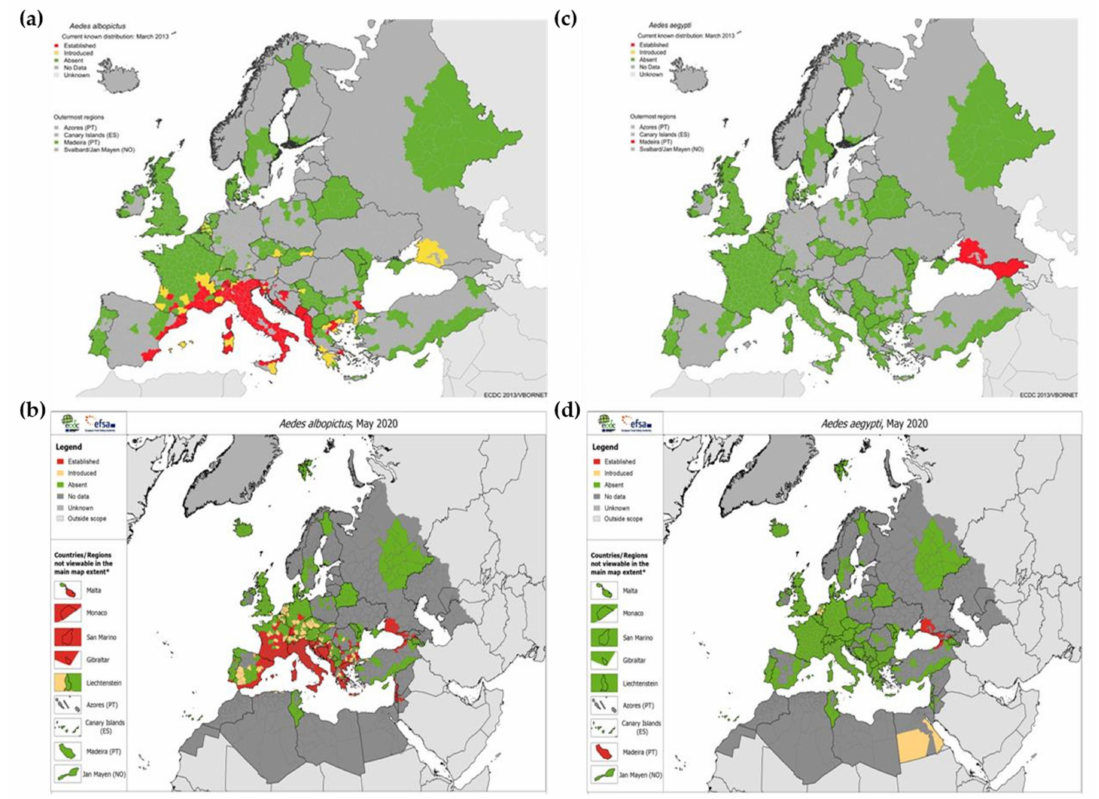
Figure 9. Expansion of Aedes spp. mosquitoes in Europe. Geographical distributions of Aedes albopictus in ( a ) March 2013 and ( b ) May 2020, and of Aedes aegypti in ( c ) March 2013 and ( d ) May 2020. Adapted from